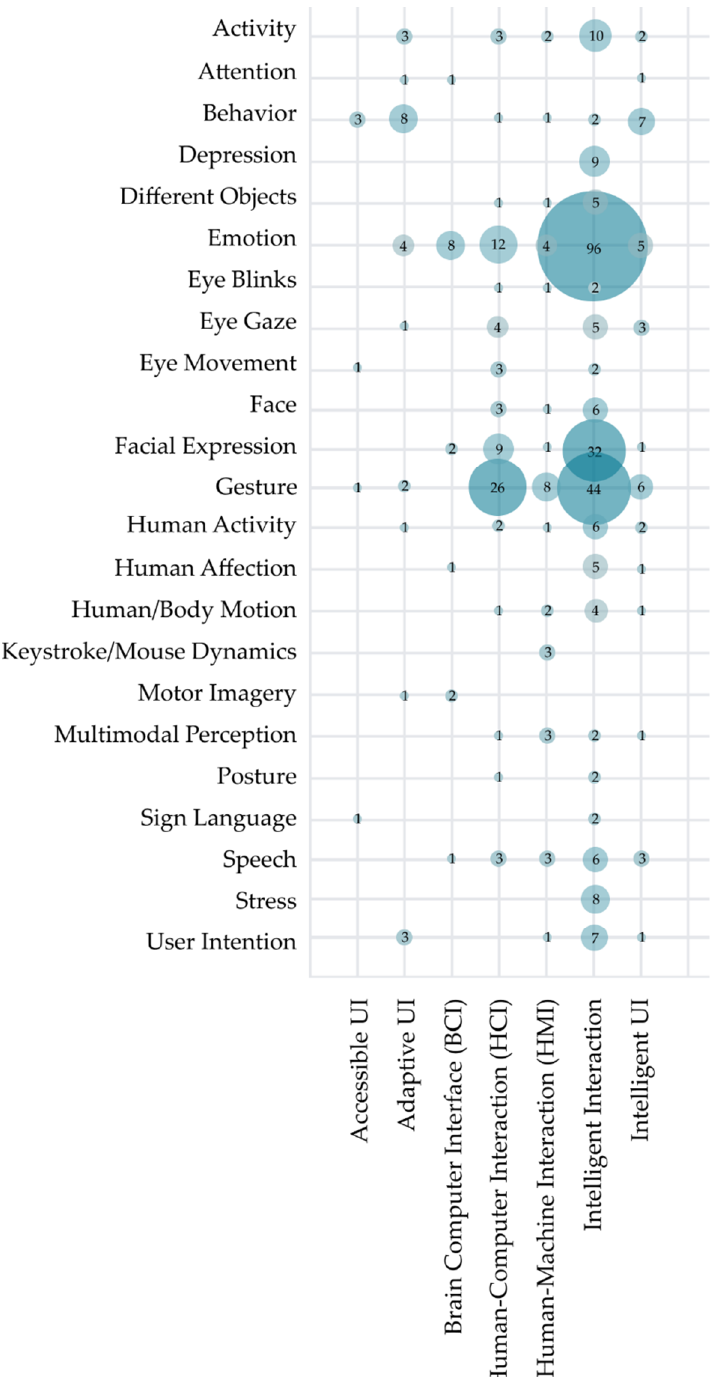
Figure 13. Distribution of HCI recognition solutions according to the research standpoint. Visualization of analyzed studies based on the primary data source used for evalu- ating the proposed solutions of the HCII and the main aim of the intelligent recognition is presented in Figure 14. The use of sensor data (165 studies), images (56 studies), and use of multiple sources (51 studies) are overall the most used data sources. However, we can observe that studies focusing on intelligent speech recognition most commonly use voice and speech (five studies), audio (four studies), or database as data sources. Studies focused on eye movement and gaze recognition most often use eye gaze as the data source, while studies focused on emotion recognition mostly use video sources. The